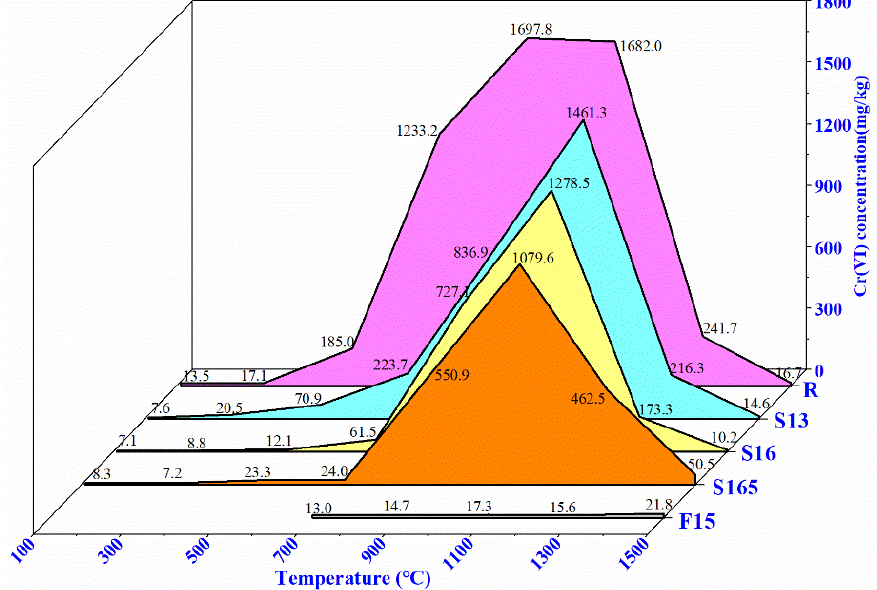
Figure 2. Cr(VI) concentration as a function of temperature in the Al 2 O 3 -CaO-Cr 2 O 3 castables. Table 4. Relative Cr(VI) reduction (%) of specimens compared to R at different temperatures.